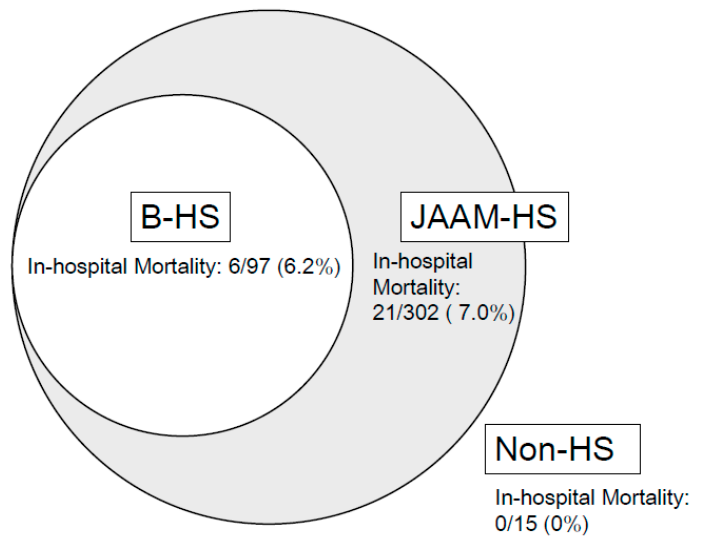
Figure 4. Distribution of HS population based on the B-HS and JAAM-HS criteria.